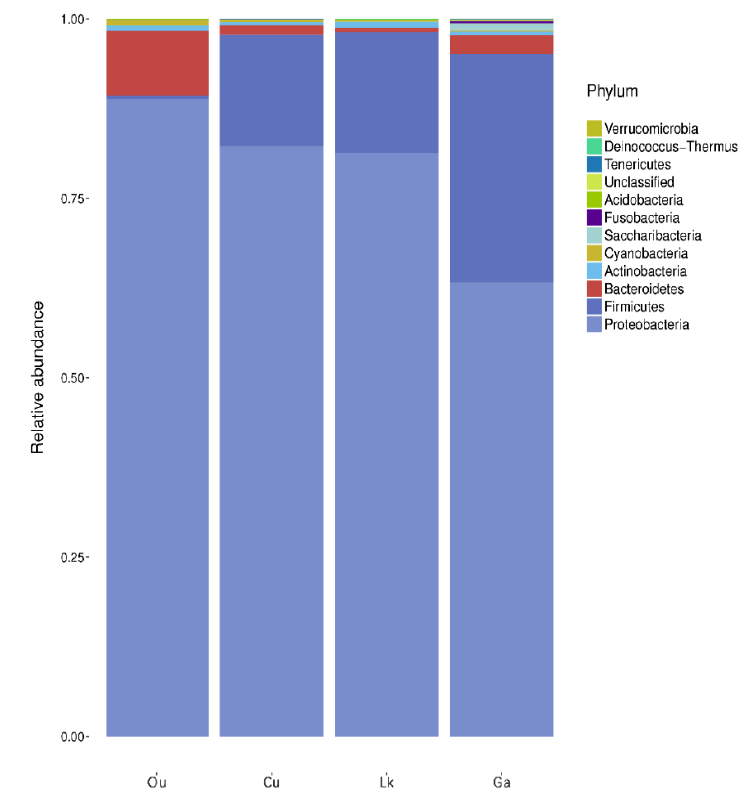
Figure 3. Taxonomic composition of gut microbes in four coral reef fishes at phylum level. Ou: O. unifasciatus , Cu: C. urodeta , Lk: L. kasmira , Ga: G. aurolineatus.